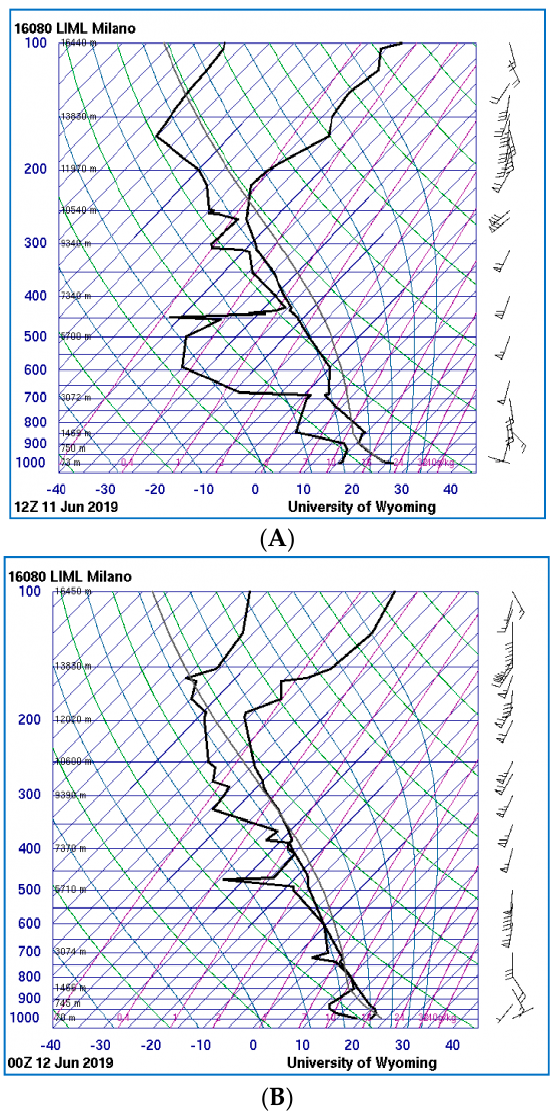
Figure 4. Radio soundings of Milano Linate recorded at 12:00 UTC of 11 June ( A ) and at 00:00 UTC of 12 June ( B ) [46] .